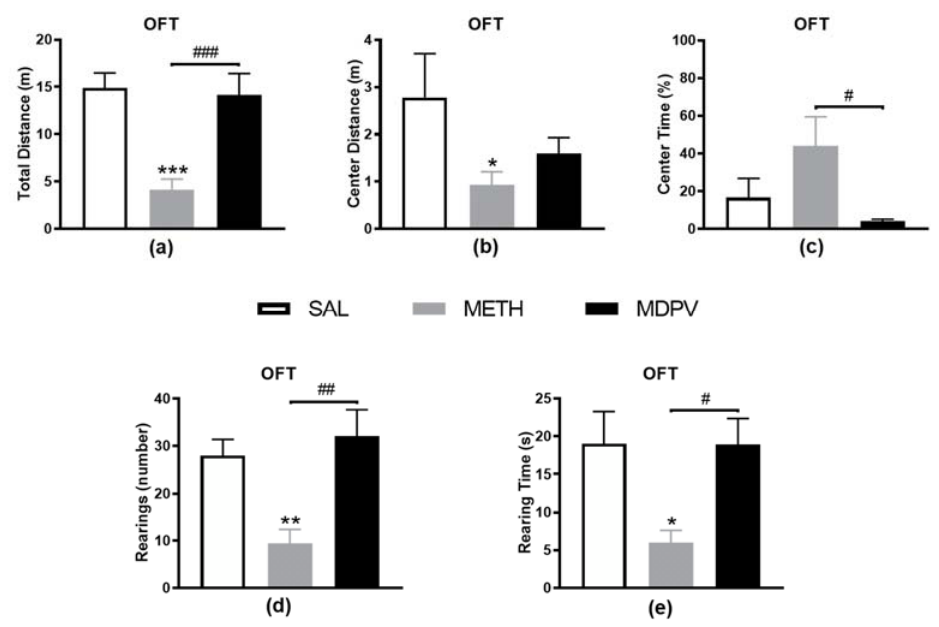
Figure 2. Effect of METH and MDPV binge paradigms on mice behavior in the open field test (OFT). ( a ) Total distance travelled (m); ( b ) center distance travelled (m); ( c ) time spent in center (%); ( d ) number of rearings; and ( e ) rearing time(s). Data are represented as mean ± SEM ( n = 8–9). Statistical comparisons for total distance traveled and rearing time were made using the one-way ANOVA followed by Tukey’s multiple comparison test and for the other parameters using the Kruskal–Wallis test followed by Dunn’s multiple comparison test (* denotes differences between SAL and METH or MDPV and # denotes differences between METH and MDPV. * or # , p < 0.05; ** or ## , p < 0.01; *** or ### , p <